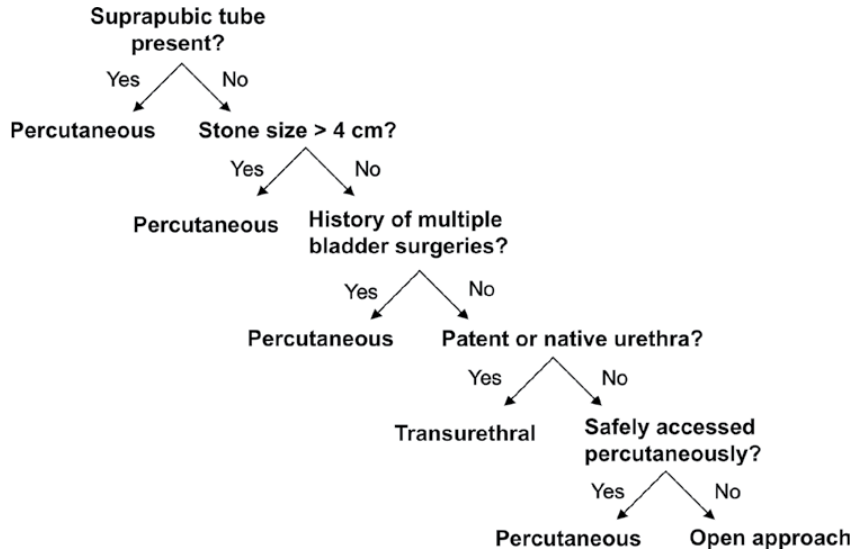
Figure 1 - Recommendations for percutaneous treatment of large bladder calculi in patients with neuropathic voiding